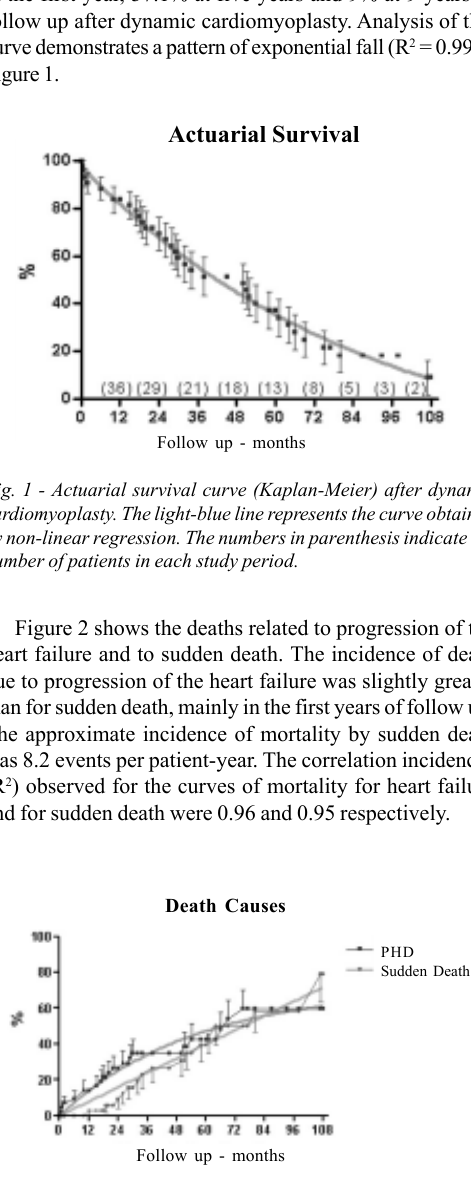
Fig. 2 - Curves of death rates by progressive heart disease (PHD) and by arrhythmia or sudden death in the post-operative follow up period after dynamic cardiomyoplasty. The light-colored lines represent the curves obtained by non-linear